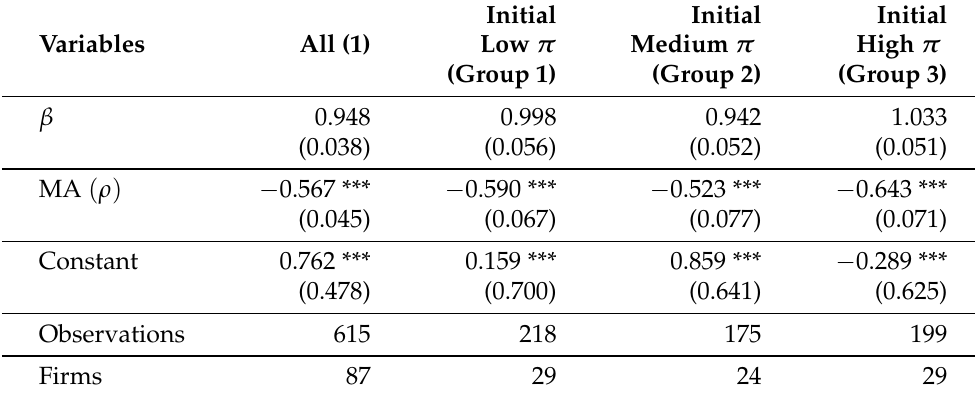
Table 4. Result from Model 2, ARMA (Gibrat’s